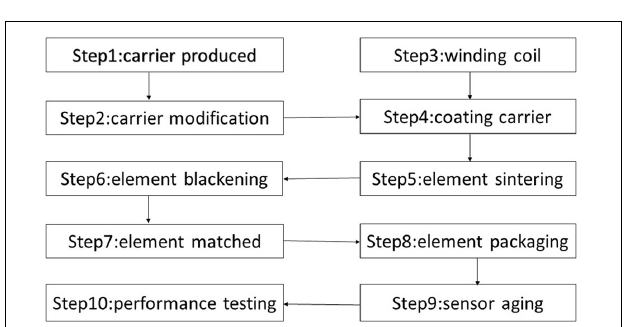
FIGURE 2 | Manufacturing process of the